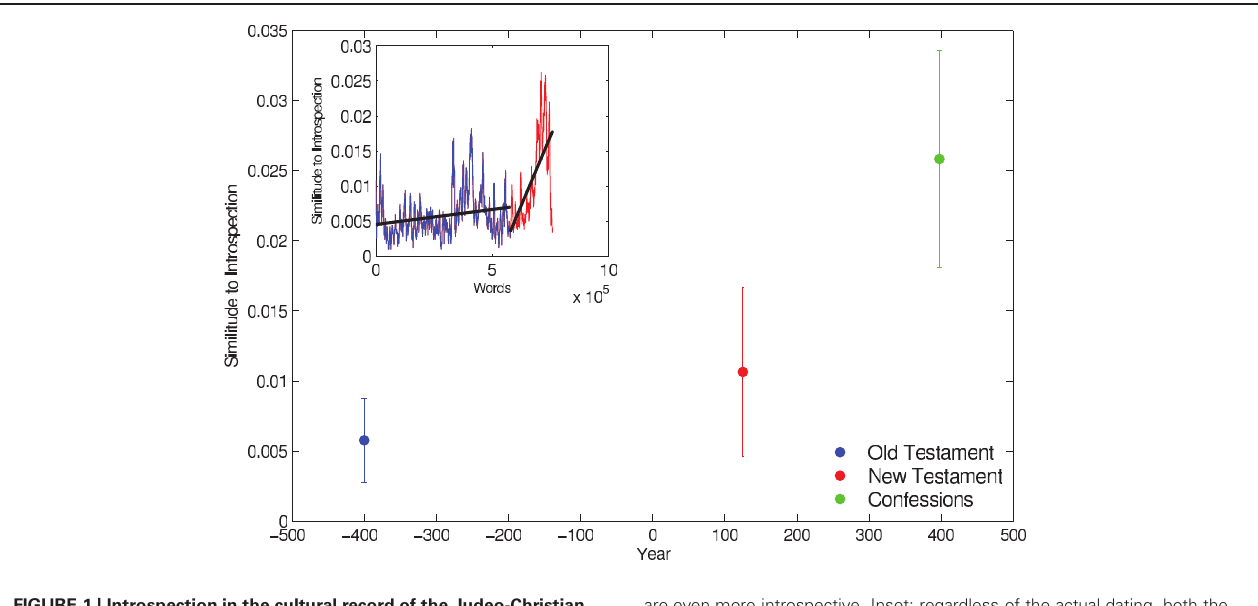
FIGURE 1 | Introspection in the cultural record of the Judeo-Christian tradition. The New Testament as a single document shows a significant increase over the Old Testament, while the writings of St. Augustine of Hippo